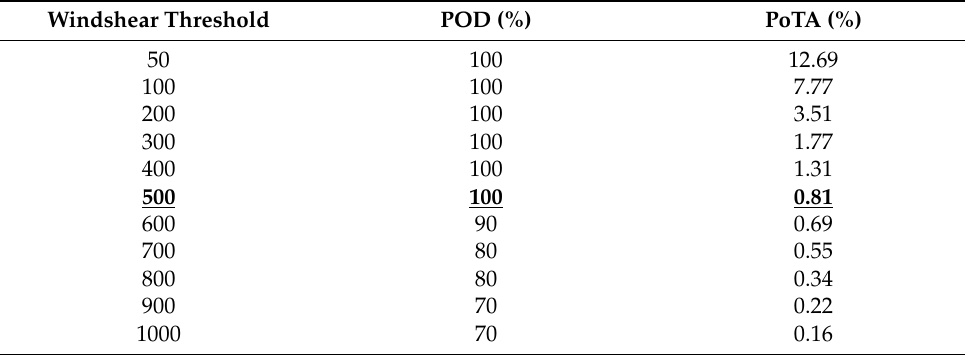
Table 2. The relationship between threshold and PoD/